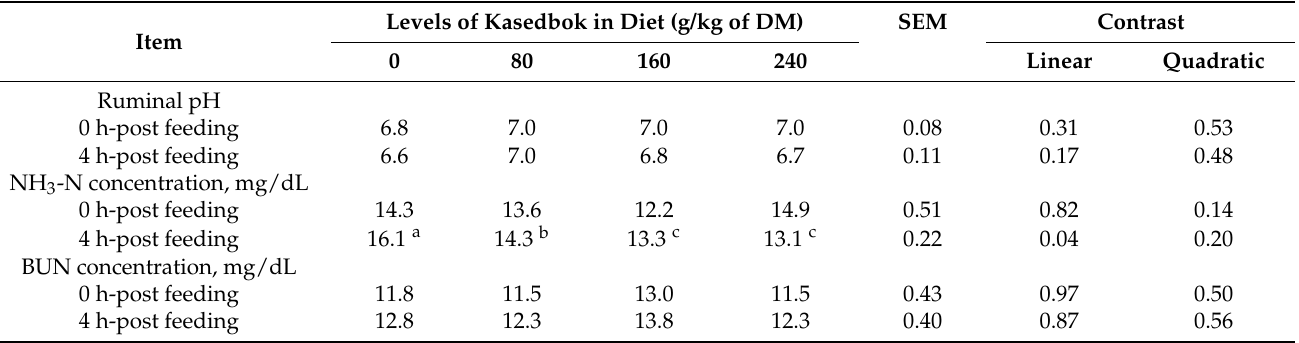
Table 3. Rumen fermentation and blood metabolites of Thai native beef cattle.